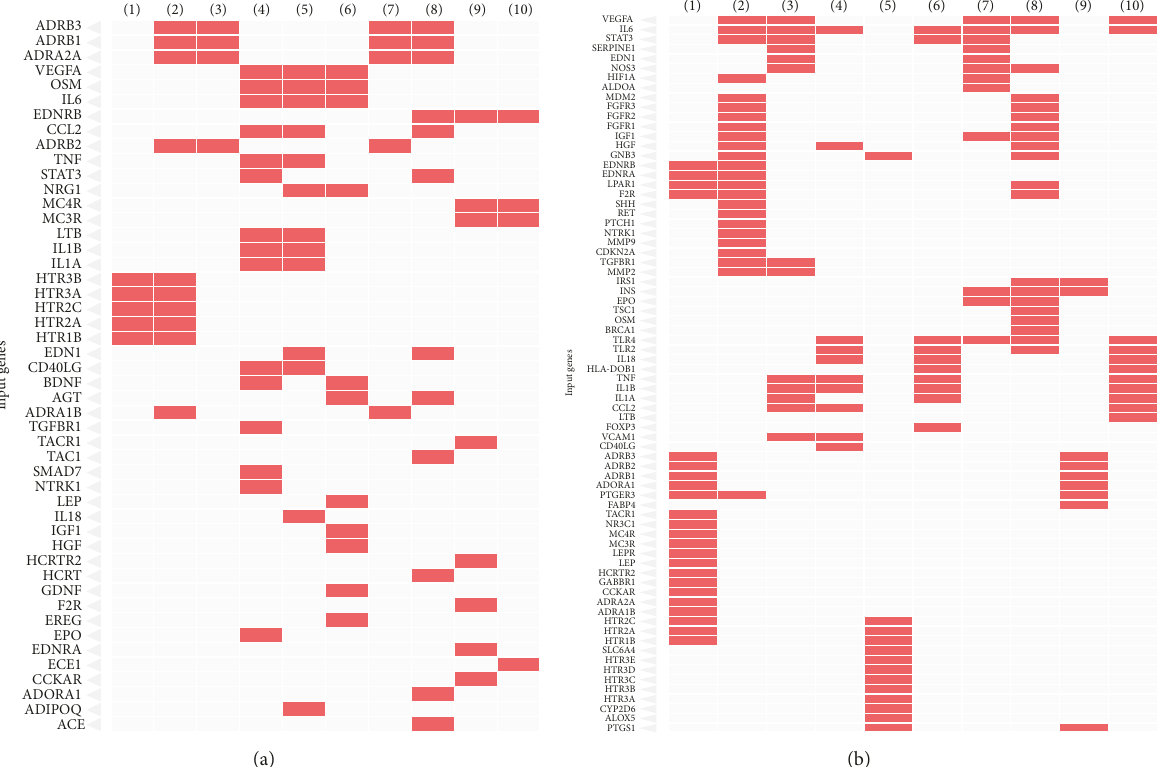
Figure 1: (a) Clustergram showing the top 10 highly significant gene ontology molecular functions associated with OSA. The selected genes ( 𝑛 = 153 ) were imported into Enrichr web tool using default setting. The top GO molecular activity was ranked based on enrichment scores (combined Fisher’s exact test 𝑃 values and the 𝑧 -scores). The top 10 associated molecular functions are ( 1 ) serotonin receptor activity, ( 2 ) G-protein coupled amine receptor, ( 3 ) catecholamine binding, ( 4 ) cytokine receptor binding, ( 5 ) cytokine activity, ( 6 ) growth factor activity, ( 7 ) adrenergic receptor activity, ( 8 ) G-protein coupled receptor, ( 9 ) G-protein coupled peptide receptor, ( 10 ) and peptide hormone binding. (b) Clustergram showing the top 10 highly significant KEEG pathways associated with OSA. The selected genes ( 𝑛 = 153 ) were imported into Enrichr web tool using default setting. The top KEEG pathways were ranked based on enrichment scores (combined Fisher’s exact test 𝑃 values and the 𝑧 -scores). The top 10 highly significant OSA disease pathways include ( 1 ) serotonin receptor interaction, ( 2 ) pathways in cancer, ( 3 ) AGE-RAGE signaling in diabetes, ( 4 ) infectious diseases, ( 5 ) serotonergic synapse, ( 6 ) inflammatory bowel disease, ( 7 ) HIF-1 signaling pathway, ( 8 ) PI3-AKT signaling pathway, ( 9 ) regulation lipolysis in adipocytes, and ( 10 ) rheumatoid